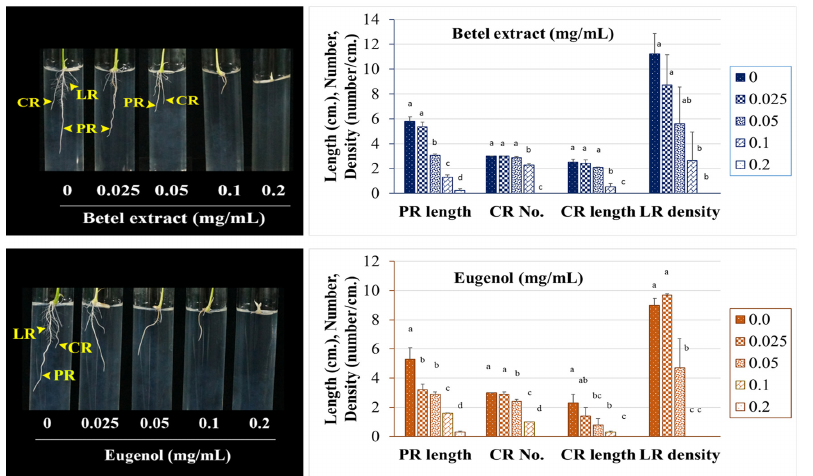
Figure 6. Effects of BE and EU on rice seedling root growth and development by means of in-gel assay. Values are means ± SD of three replications ( n > 30). Different superscript letters on the bars indicated statistically significant differences of values among different concentrations at p < 0.05. PR: primary root; LR: lateral root; CR: crown root .